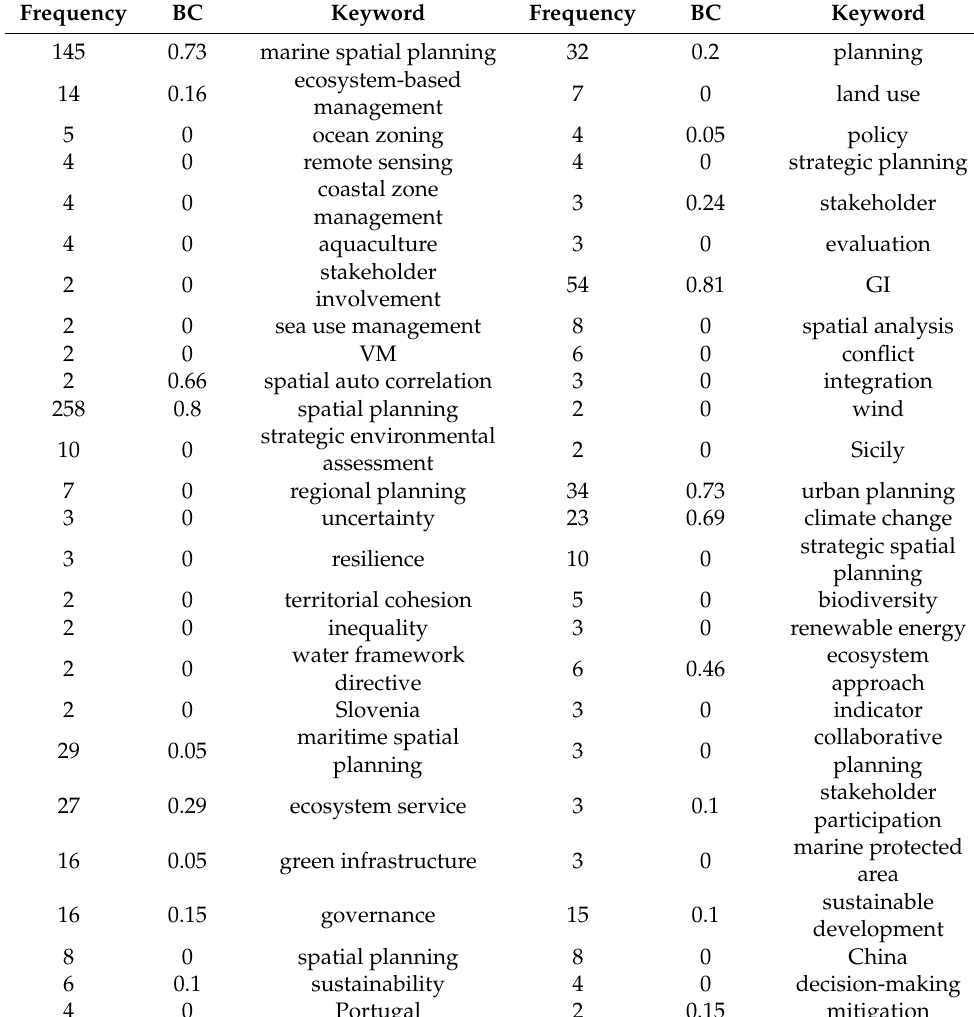
Table 5. Keyword frequency and betweenness centrality in the field of spatial planning based on